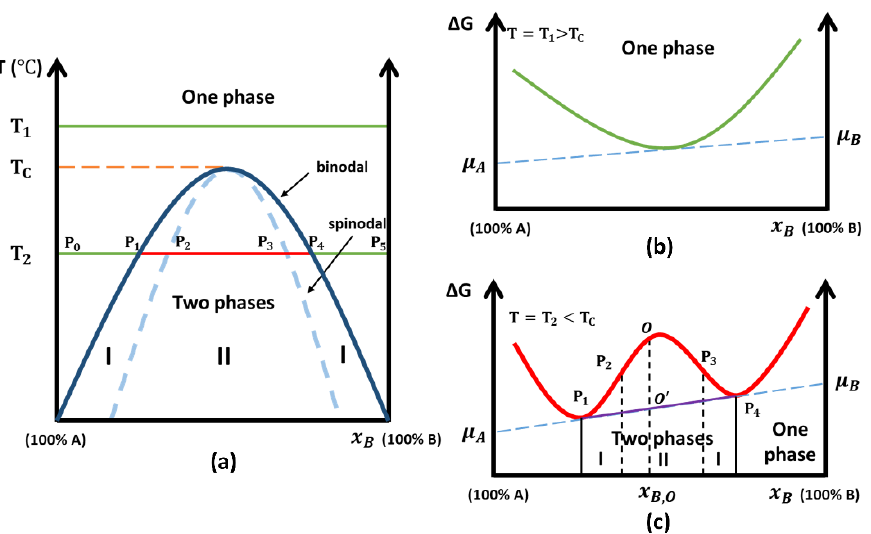
Figure 3. ( a ) Schematic two-liquid immiscibility region showing binodal (zone I) and spinodal (zone II); ( b ) Sketch of the Gibbs free energy curve versus composition x B (mole fraction of component B) for temperature T 1 where T 1 > T C ; and ( c ) Gibbs free energy curve versus composition x B (mole fraction of component B) for temperature T 2 where T 2 < T C . Binodal decomposition occurs in zone I, and spinodal decomposition occurs in zone II [35,79,80].